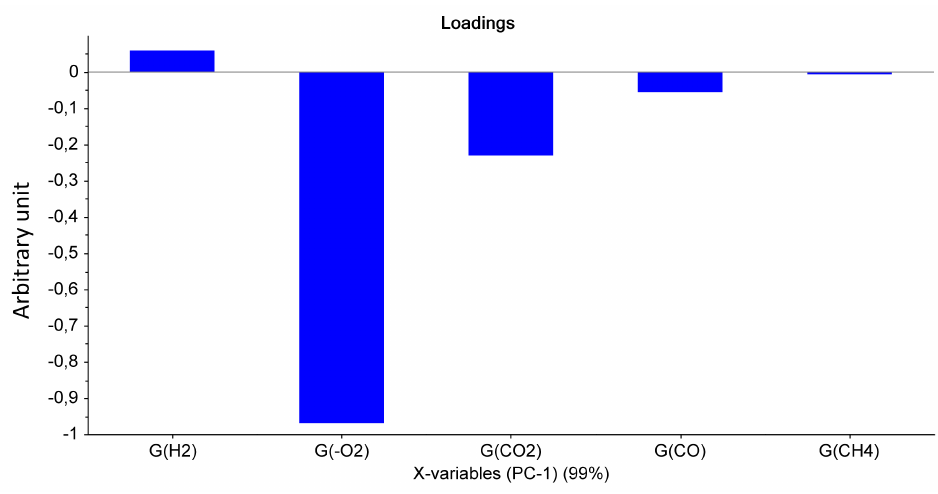
Figure 14. PCA loading for PC1 (Mod